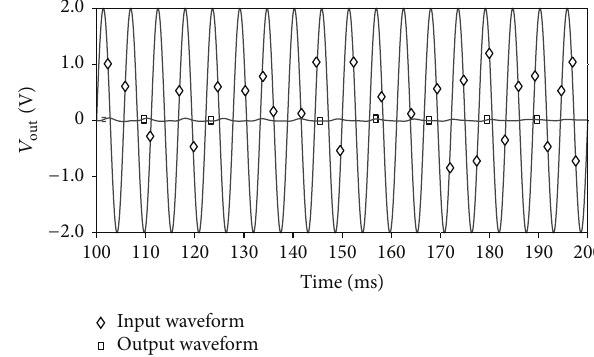
Figure 12: Input and output response at